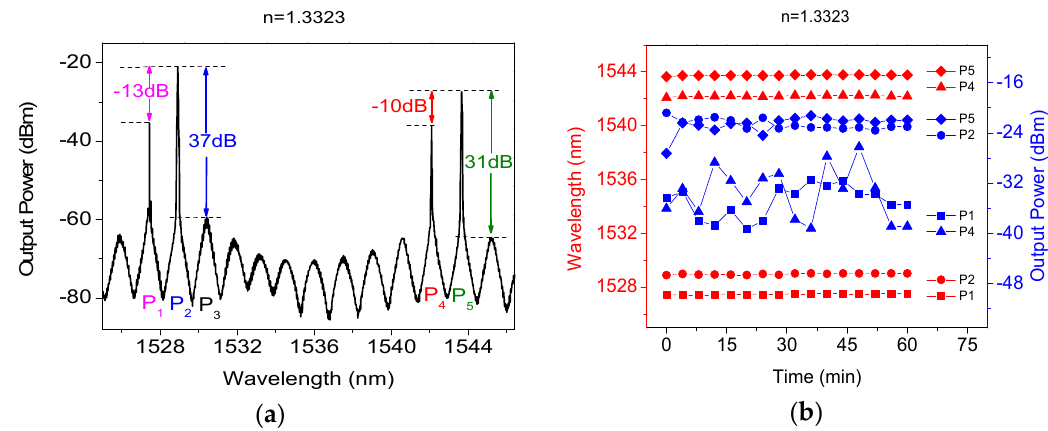
Figure 5. Refractive index response: ( a ) Quadruple-wavelength laser emission output for distilled water immersion (RIU 1.332); ( b ) Stability analysis for refractive index surrounding alteration (wavelength (red) and power (blue)).